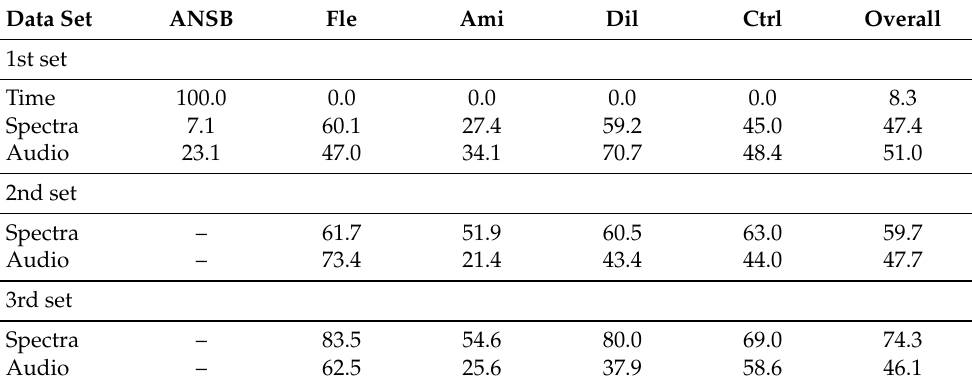
Table 3. Accuracy percentage of supervised learning autoencoders with several in-order training